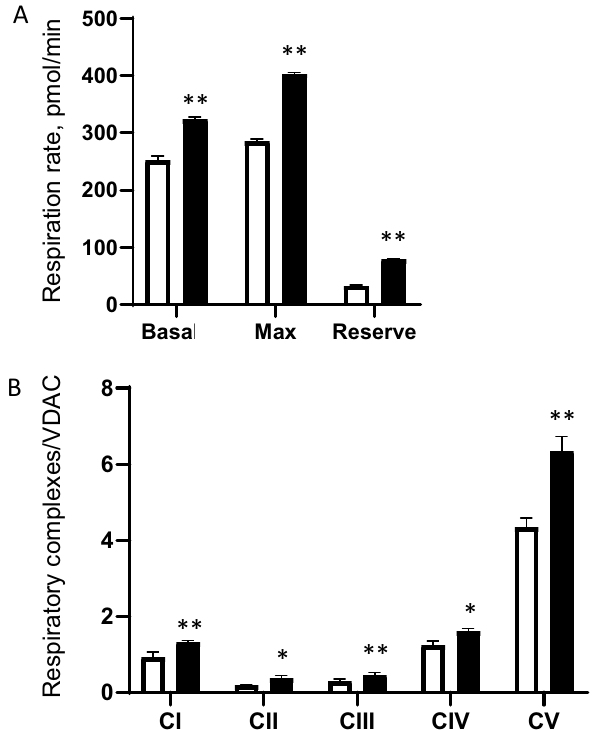
Figure 2. Treatment of KiPS cells with plant extract improved their mitochondrial activity. ( A ) Seahorse analysis of the metabolic features of KiPS-40. Non-treated controls (white bars) or treated KiPS-40 with 1% Jasminum Officinale Flower extract & Palmaria Palmata extract, 1% hydrolyzed soy protein extracts (black bars) at day 4 after the beginning of their differentiation and for 4 days. Basal OCR, maximum respiration in the presence of FCCP and spare respiratory capacity (difference between the FCCP-induced OCR and the basal OCR) was determined. (n = 2 experiments and 5 replicates) ( B ) Quantification of mitochondrial complexes by WES analysis of respiratory complexes. Statistical significance was determined by a Student’s t test. ** P < 0.01 and * P < 0.05, errors bars: